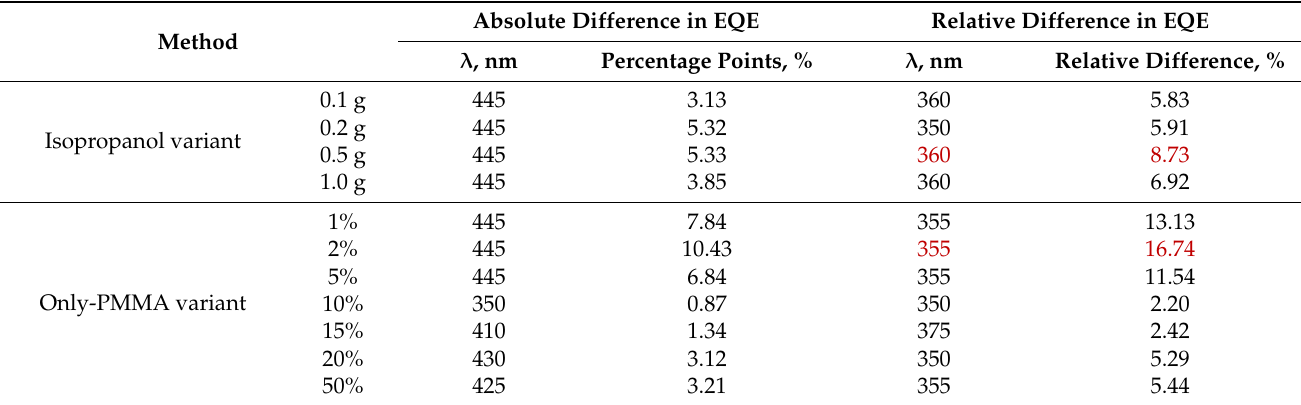
Table 2. The most important points for EQE characteristic for two variants of deposition for pigments G. Absolute Difference in EQE Method